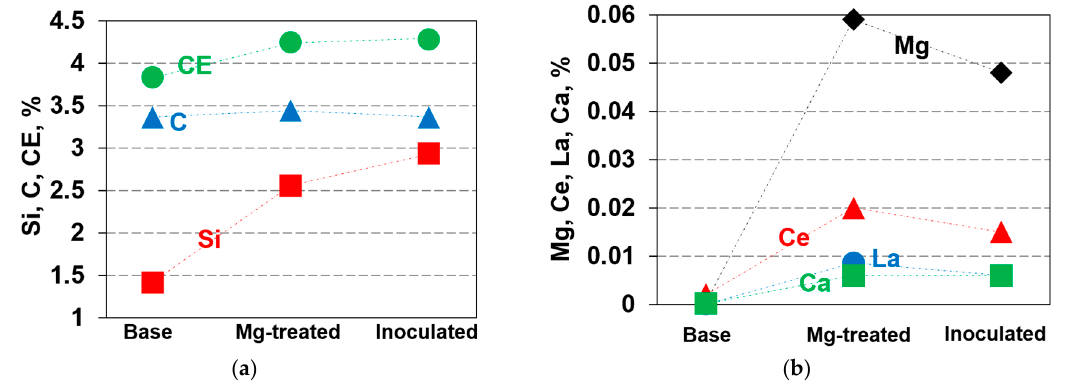
Figure 4. Base composition ( a ) and active elements ( b ) evolution in double-treatment process. CE—carbon equivalent.